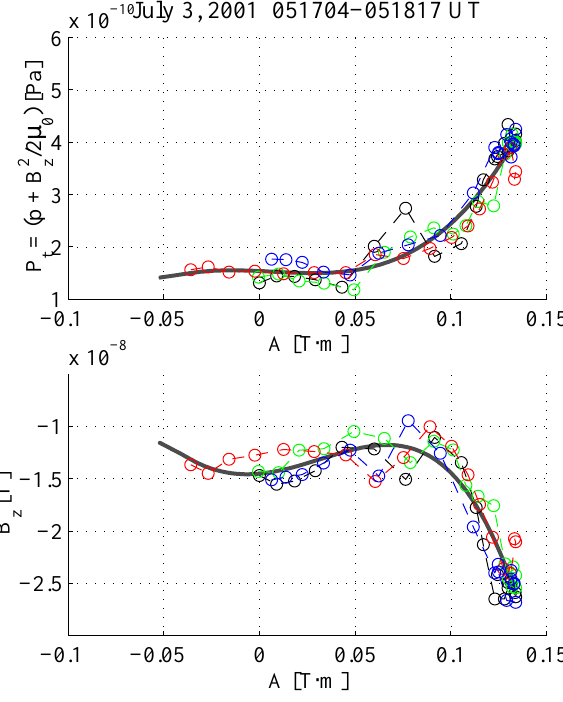
Fig. 3. Transverse pressure P t = (p + B 2 z / 2 µ 0 ) (top) and axial mag- netic field component B z (bottom) versus partial magnetic vector potential A during the interval 1 of the 3 July 2001 event. The fitted curve is a polynomial function of A and is determined using the data points from all four spacecraft. Extrapolations at small and large A values are the straight-line